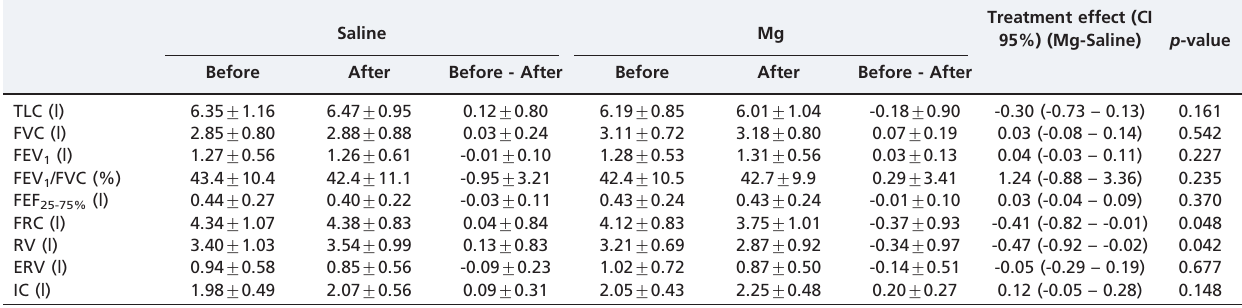
Table 2 - Effects of Mg loading on the pulmonary function parameters of 20 COPD patients*. Saline Mg